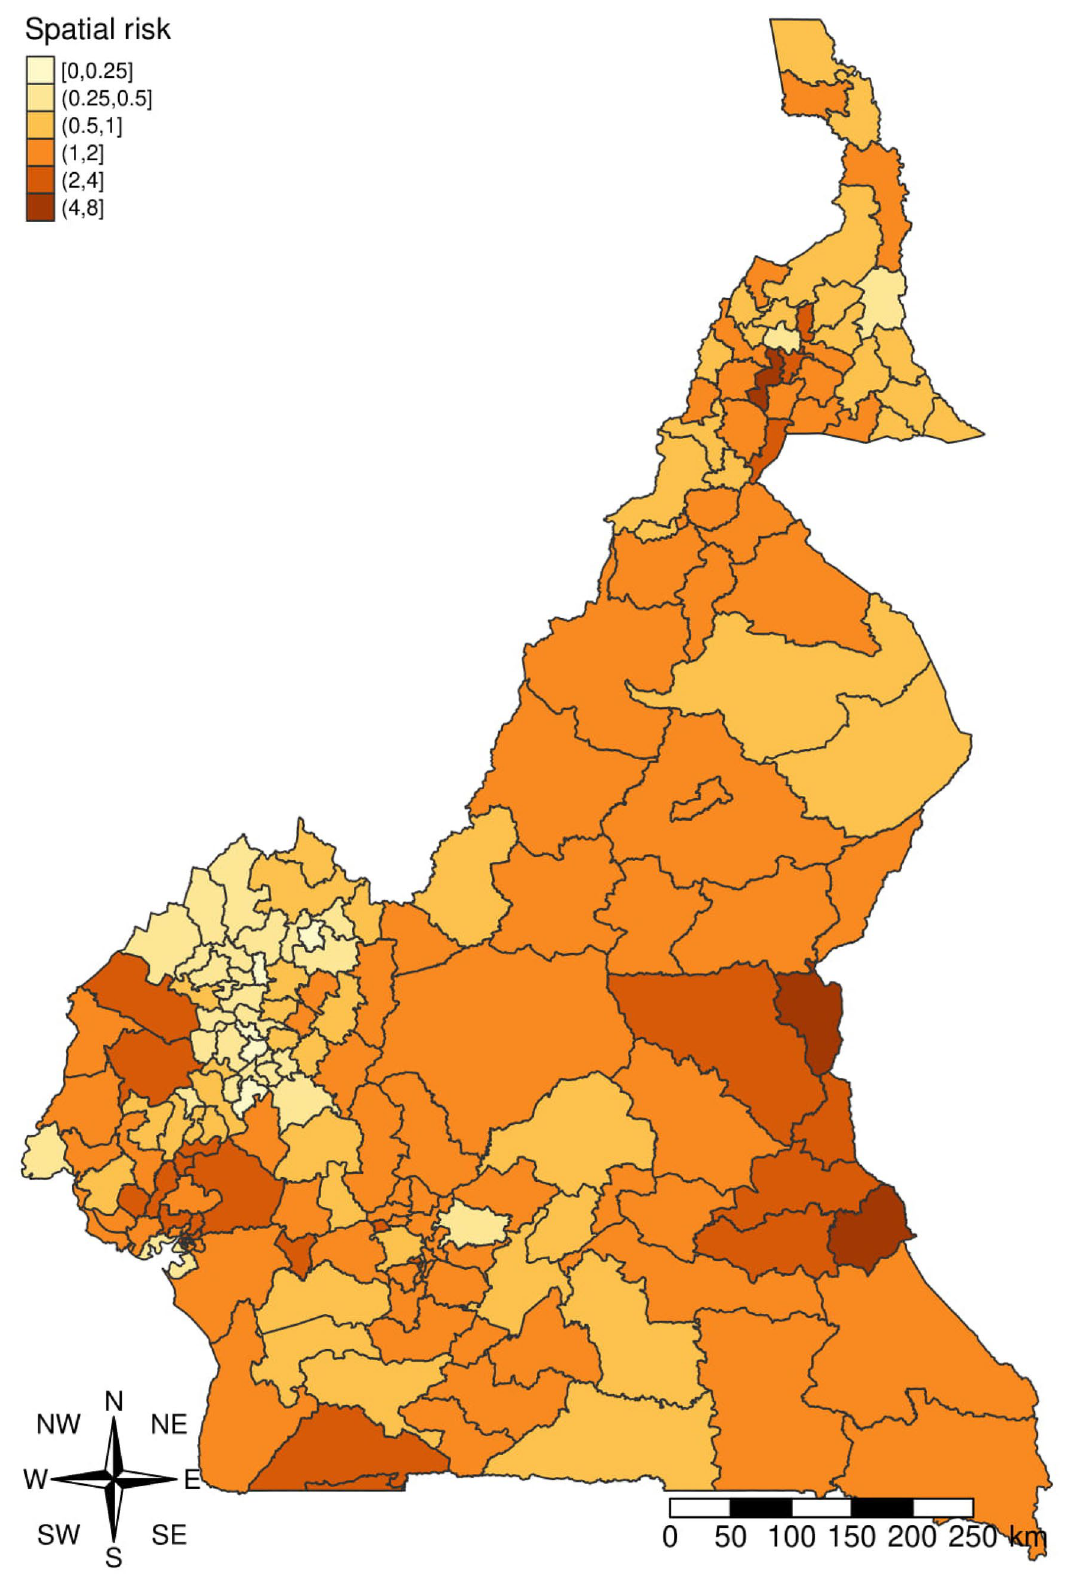
Figure 4. Modelled malaria risk map. The spatial risk map shown here is the result of the Bayesian model with the lowest DIC. The map was generated with tmap package of R software version 4.0.2 (URL: https:// cran.r- proje ct. org/ web/ packa ges/ tmap/ vigne ttes/ tmap- getst arted.